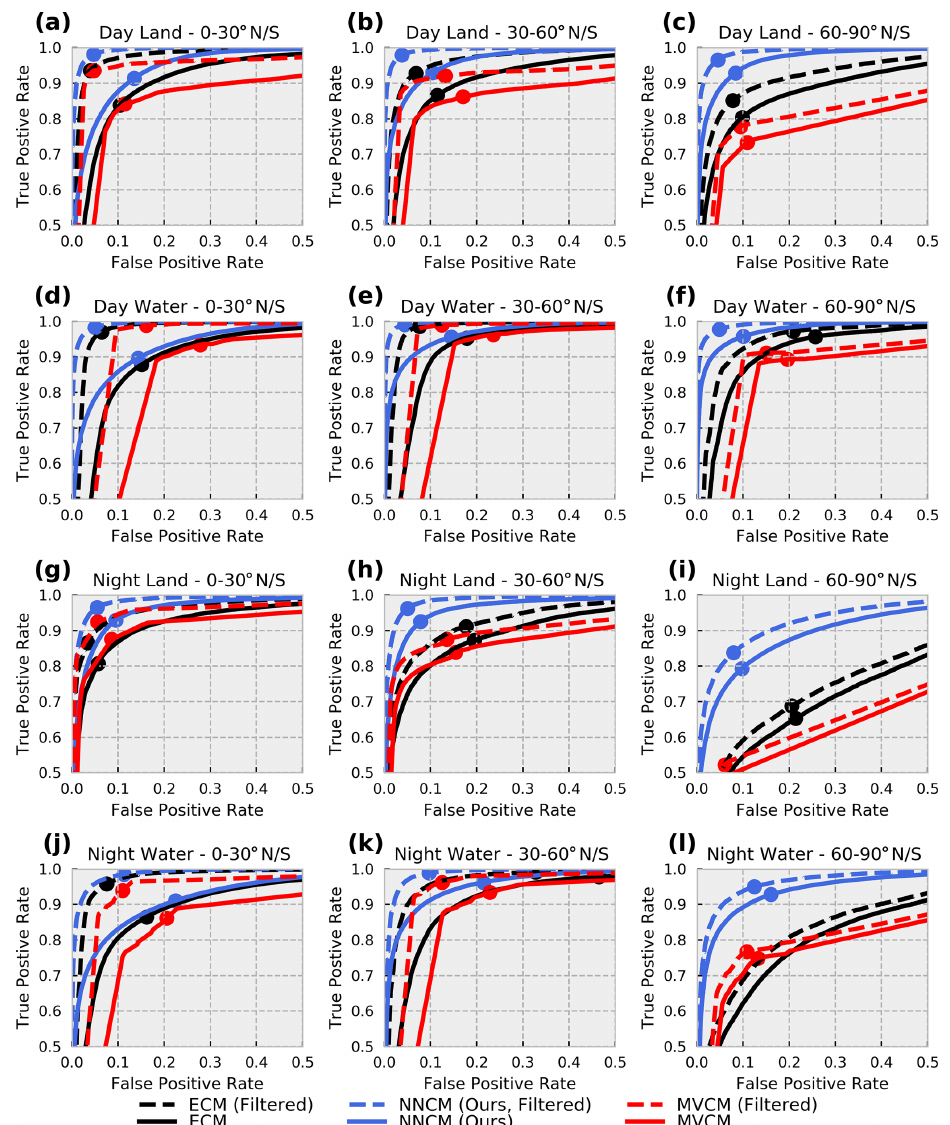
Figure 6. Receiver operating characteristic (ROC) curves for all three cloud masks. The text above each subplot indicates the subset of collocations for which the curves are plotted. Note that the x - and y -axis limits are somewhat atypical for ROC curve plots and are chosen here to emphasize the differences between the masks and different datasets. The TPR and FPR for the model using the standard threshold of 0.5 for the neural network and ECM as well as the integer cloud mask for MVCM are also shown with similarly colored